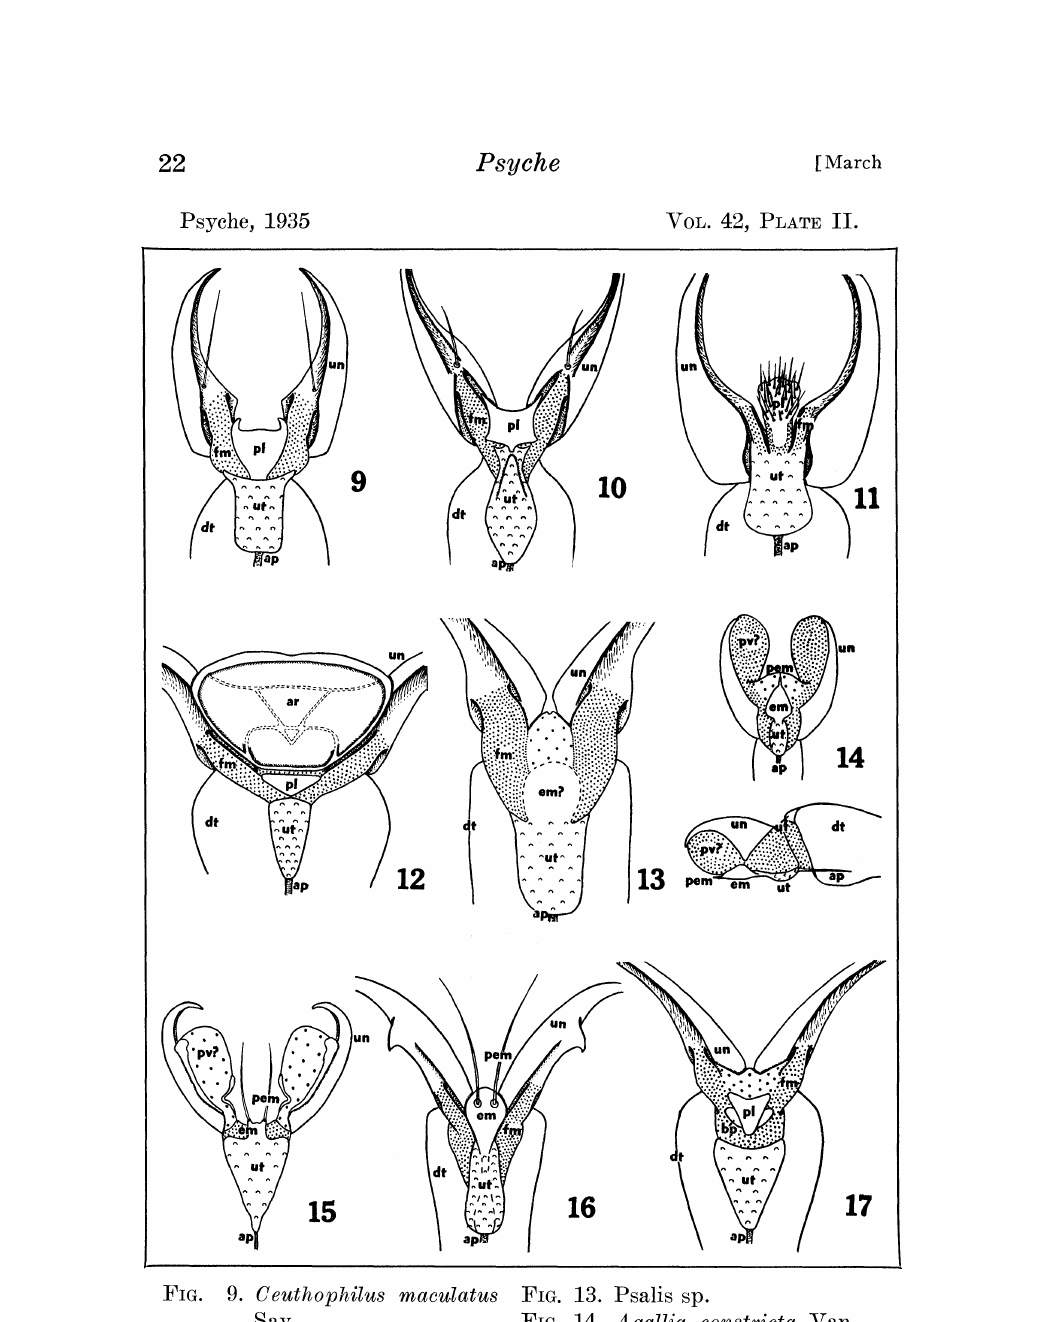
F. 14. Agallia constricta Van Duzee, ventxal and lateral views ]IG. 15. Brochymena arborea Say. FIG. 16. Phyllophaga fusca Froe- lich. Fro. 17. Corydalis cornuta